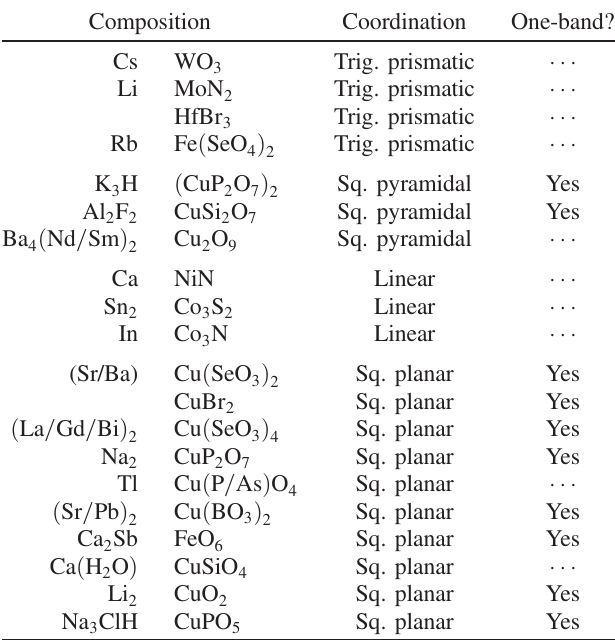
with extended electron hopping pathways and the TM co- ordination environment. The third column indicates whether the underlying electronic structure is found to be one-band in